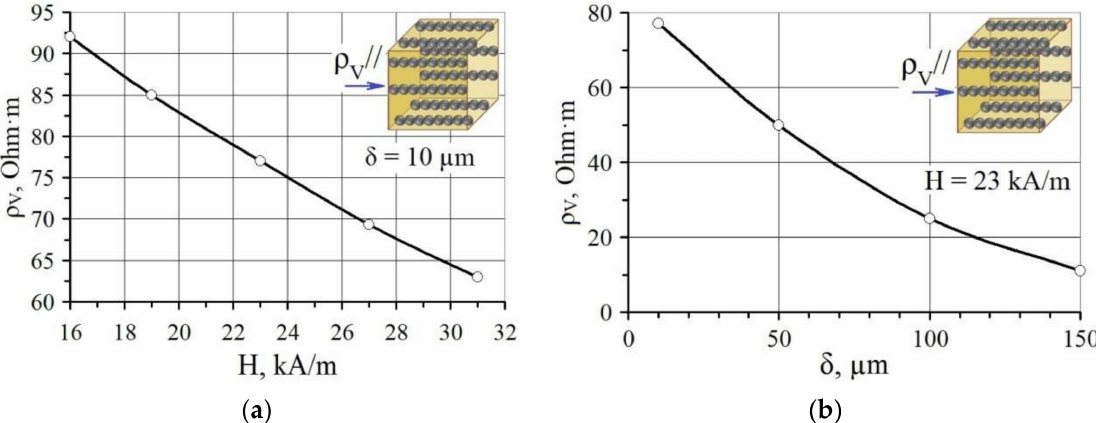
Figure 15. The effect of magnetic field strength ( a ) and FMF particle size ( b ) on resistivity of Fe/HEMA-gr-PVP composites (HEMA:PVP = 70:30 mass parts, [Fe] = 40